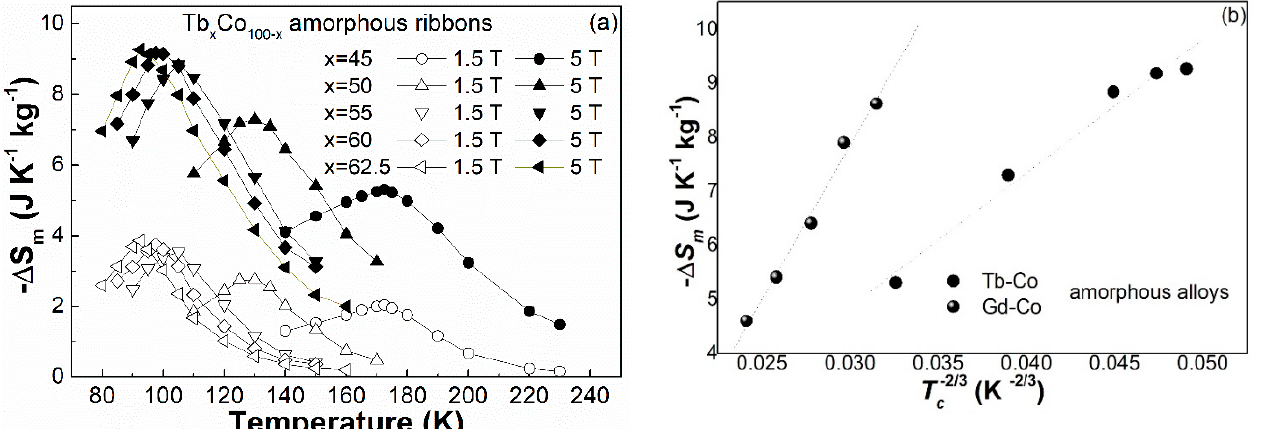
Figure 4. ( a ) The ( −Δ S m )- T curves of the Tb x Co 100 − x (x = 45, 50, 55, 60, 62.5) amorphous ribbons under the magnetic field of 1.5 T and 5 T; ( b ) the linear fittings of T c − 2/3 vs. −Δ S mpeak plots for the Gd–Co and Tb–Co amorphous alloys.